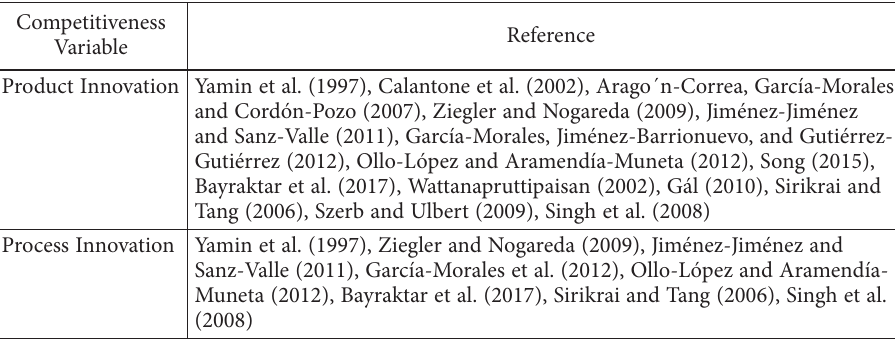
Table 1. The SME competitiveness variable pool Competitiveness Variable